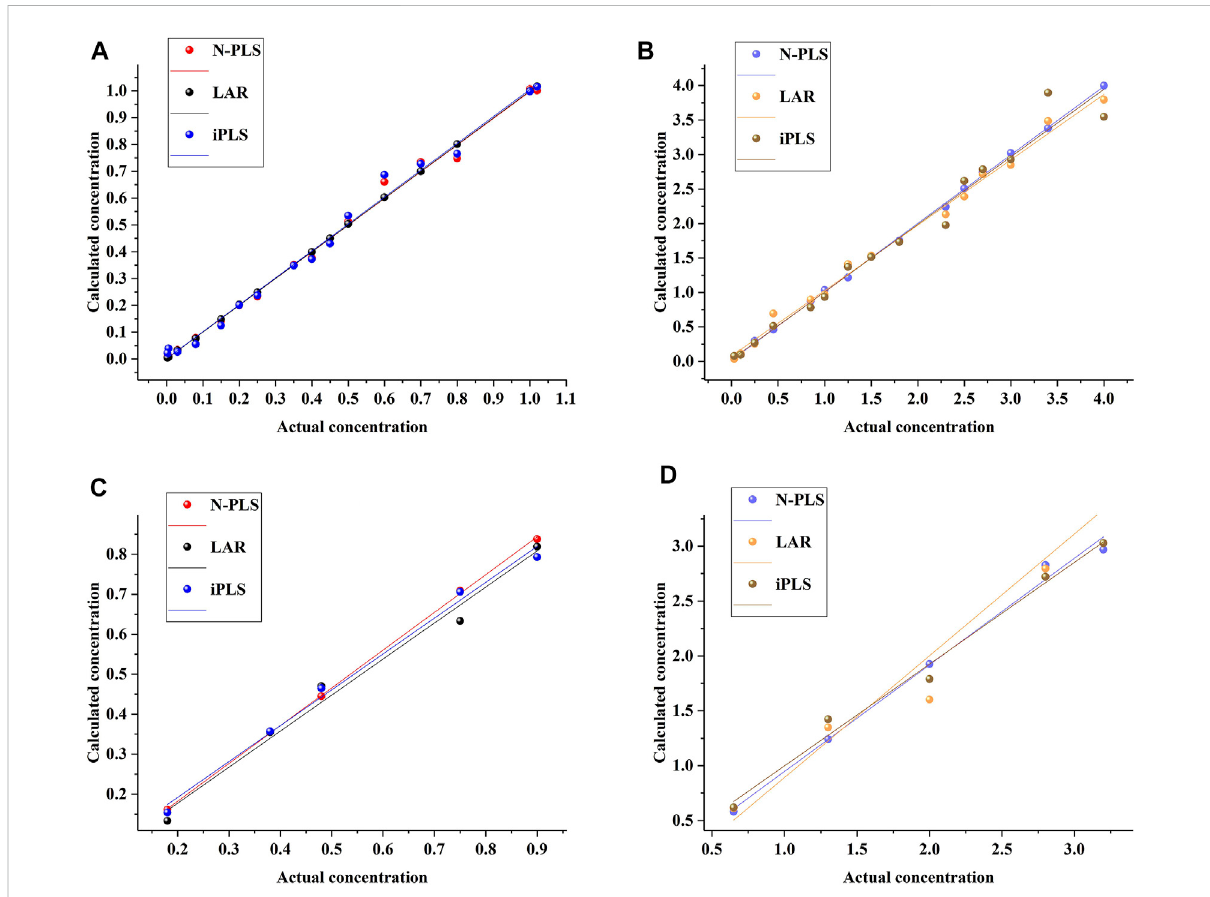
FIGURE 3 The relationship between the actual concentrations and calculated concentrations by using different methods for aesculin (A) and aesculetin (B) in the calibration set and aesculin (C) and aesculetin (D) in the prediction set.